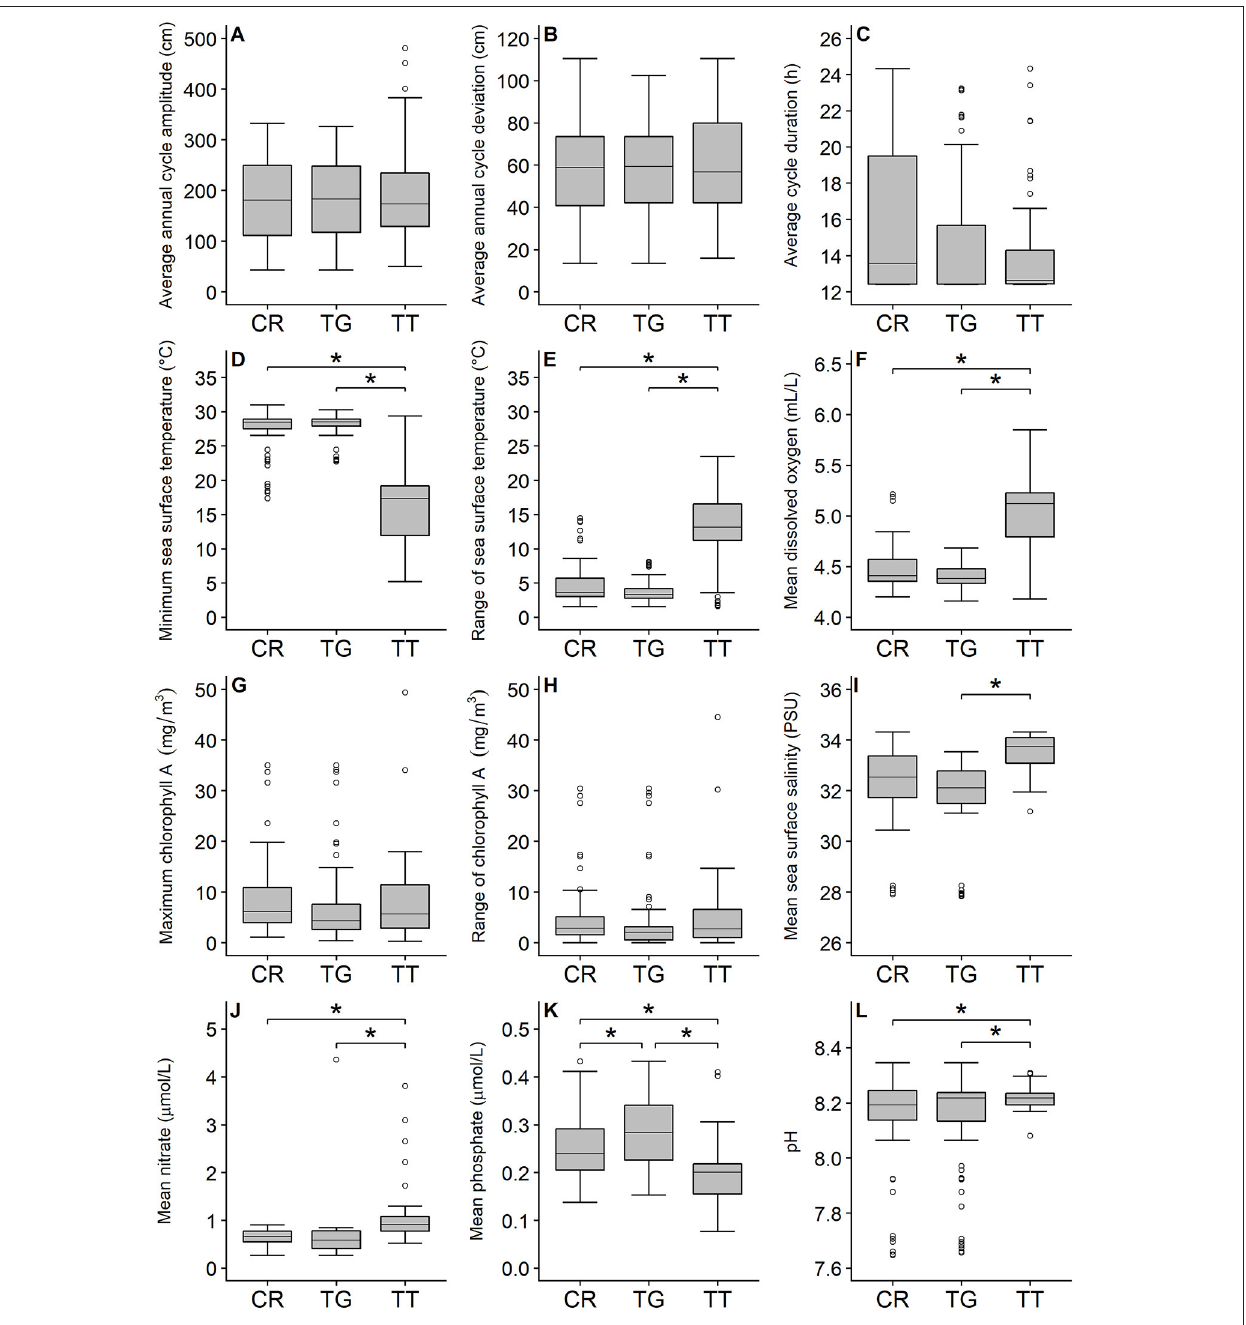
FIGURE 2 | Comparison of the three horseshoe crab species (CR, C. rotundicauda ; TG, T. gigas ; TT, T. tridentatus ) showing the variation of 12 key environmental variables. Variable and unit are shown on the y-axis. Gray boxes indicate 50% of the sample points and are limited by the 1st (Bottom) and 3rd quartiles (Top) . Black, horizontal lines within the gray boxes display the medians. Comparisons between C. rotundicauda and the two Tachypleus species for salinity were excluded because of absence of environmental data for inland waters. Asterisks show significant ( < 0.05) differences between species.